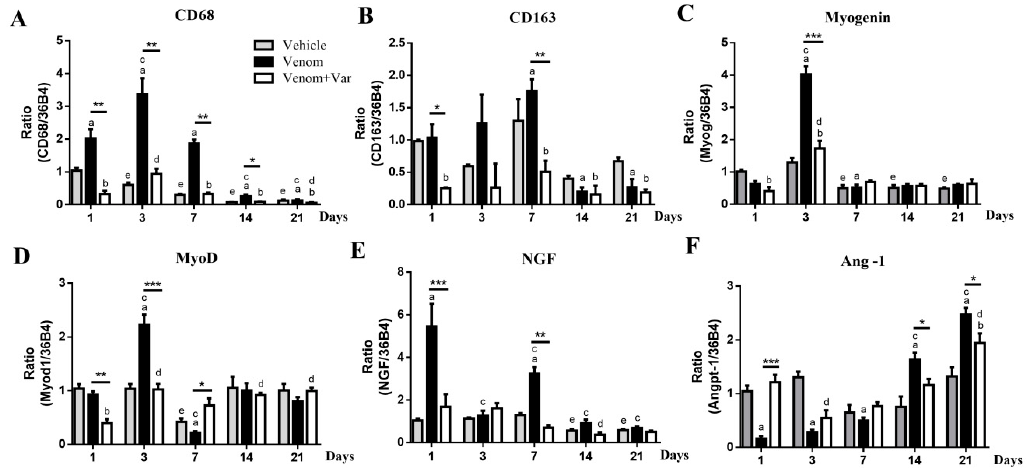
Figure 4. Gene expression profile of muscle regeneration. ( A , B ) Molecular markers of M1 and M2 macrophages, CD68 and CD163 exhibited their maximum expression at day 3 and day 7; ( C , D ) show the relative expression of Myogenin and MyoD, which represented the progression of muscle regeneration; ( E ) NGF expression was significantly increased in the venom group, indicating major nerve repair during the early stage of envenomation; ( F ) The bifacial variation of Ang-1 expression indicated early initiation of microvascular repair in the varespladib group, and a deferred repair in the venom group. Results were presented as means ± SD ( n = 3). * p : Venom vs. Venom + Var ( p < 0.05), ** p < 0.01, *** p < 0.001, “a” p < 0.05 Venom vs. Vehicle, “b” p < 0.05 Venom + Var vs. Vehicle, “c” p < 0.05 Venom